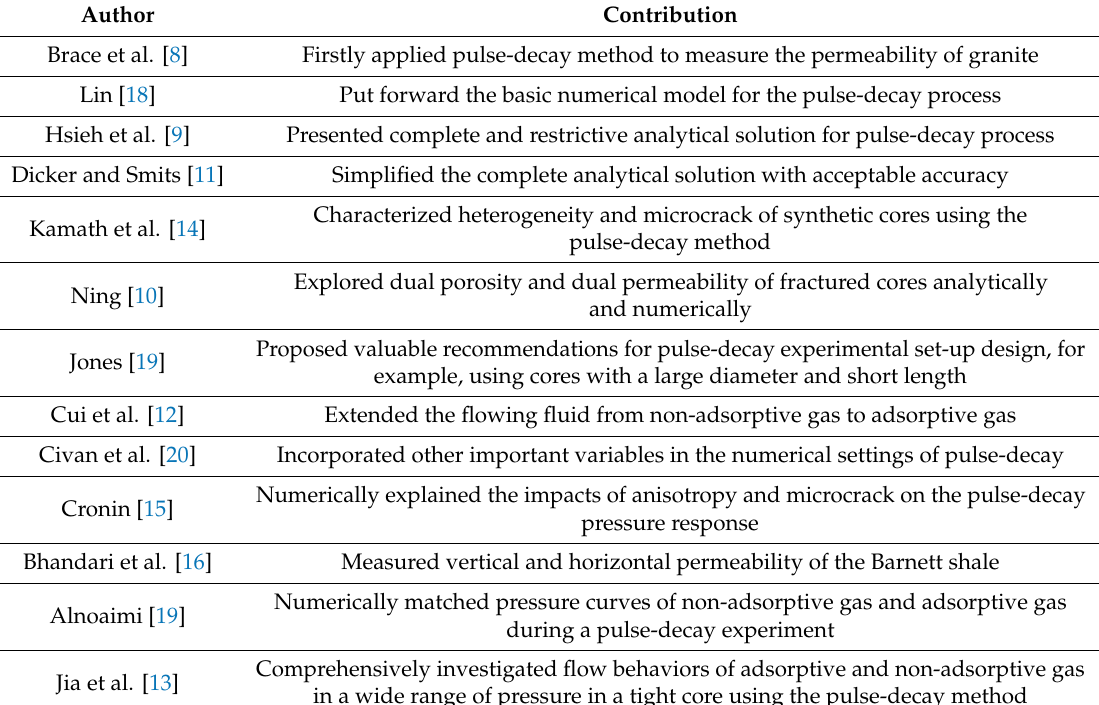
Table 1. Representative work regarding the pulse-decay method in tight